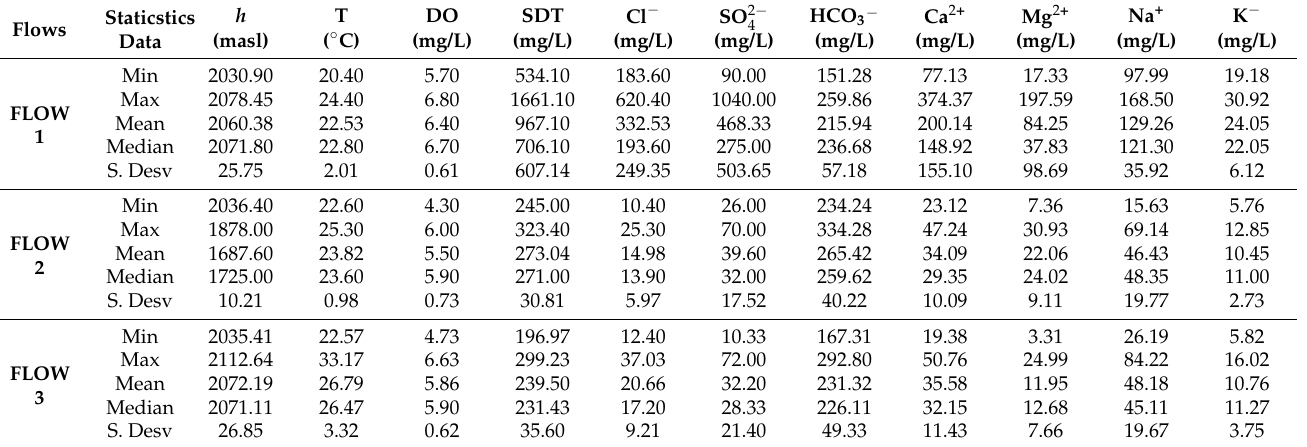
Table 4. Grouping of flow systems as a result of 3D geostatistical analysis of hydraulic head and physicochemical parameters of water, ( h = Hydraulic Head, TDS = Total dissolved solids, and DO = Dissolved